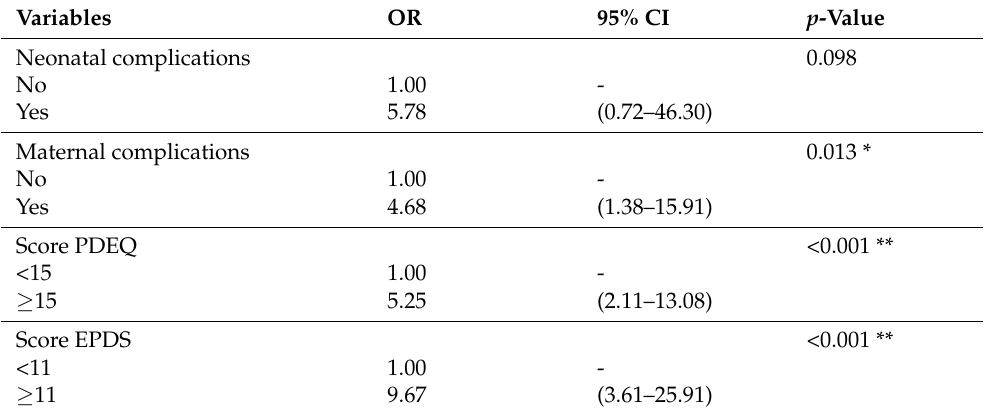
Table 7. Variables associated with traumatic childbirth defined by criterion A for traumatic events according to the DSM-5 step-wise approach ( p < 0.25 for selection and parsimonious multivariate